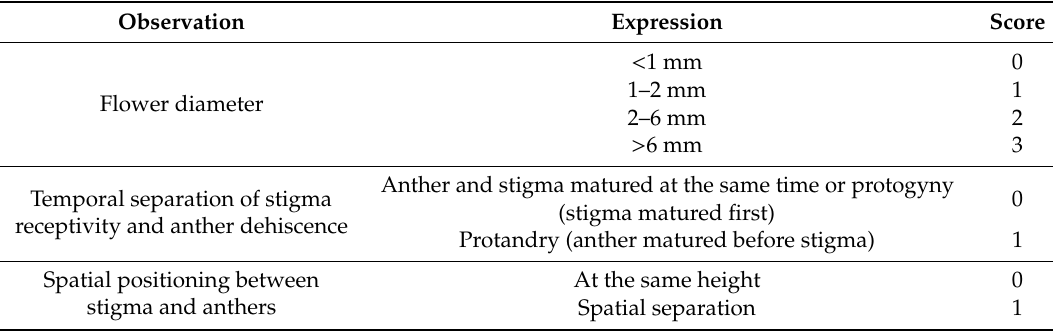
Table 2. Scoring standards of outcrossing